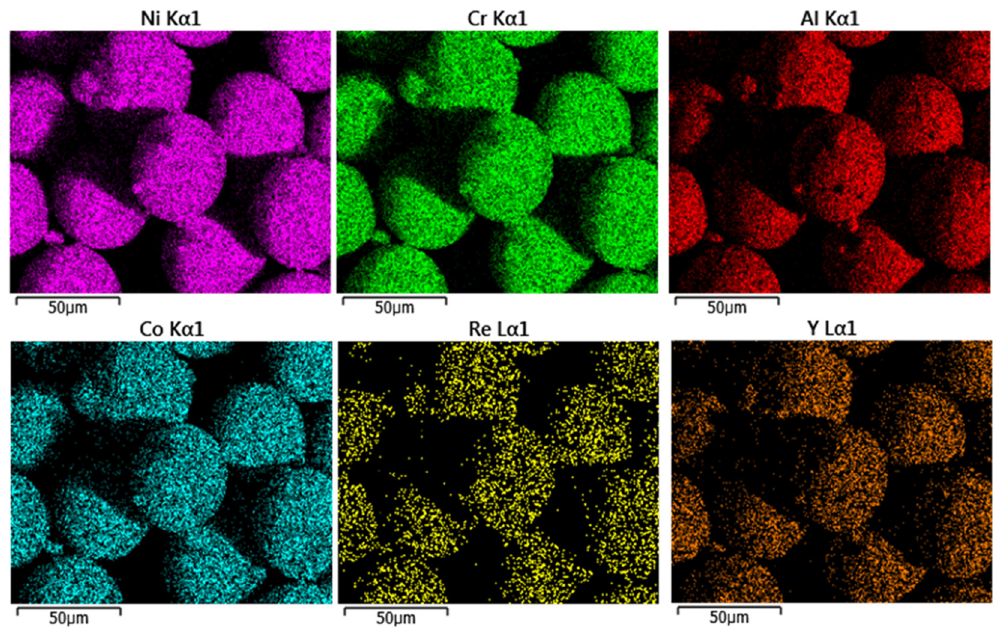
Figure 2. Energy dispersive spectroscopy (EDS) map showing the composition of NiCoCrAlYRe powder particles.